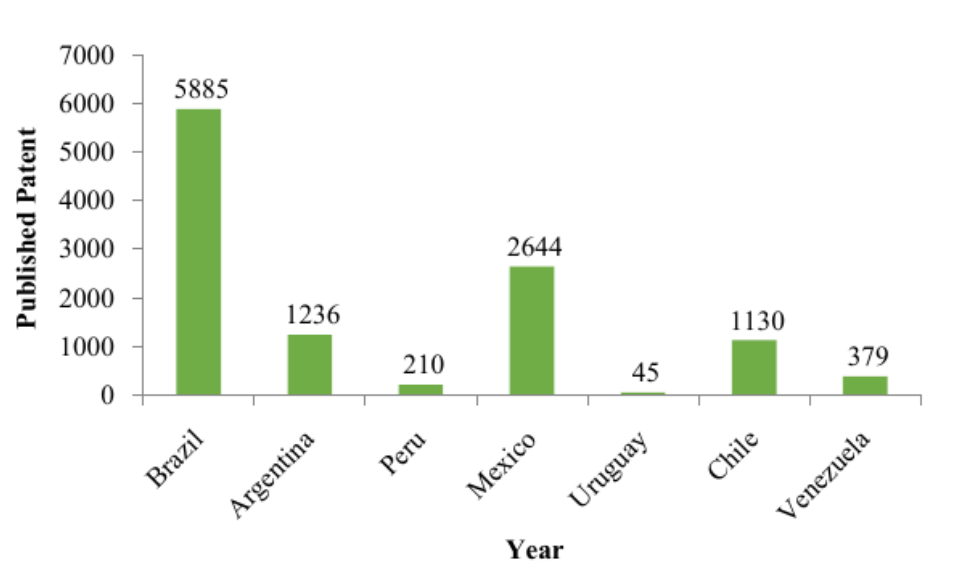
Figure 10. The number of published patents in South American